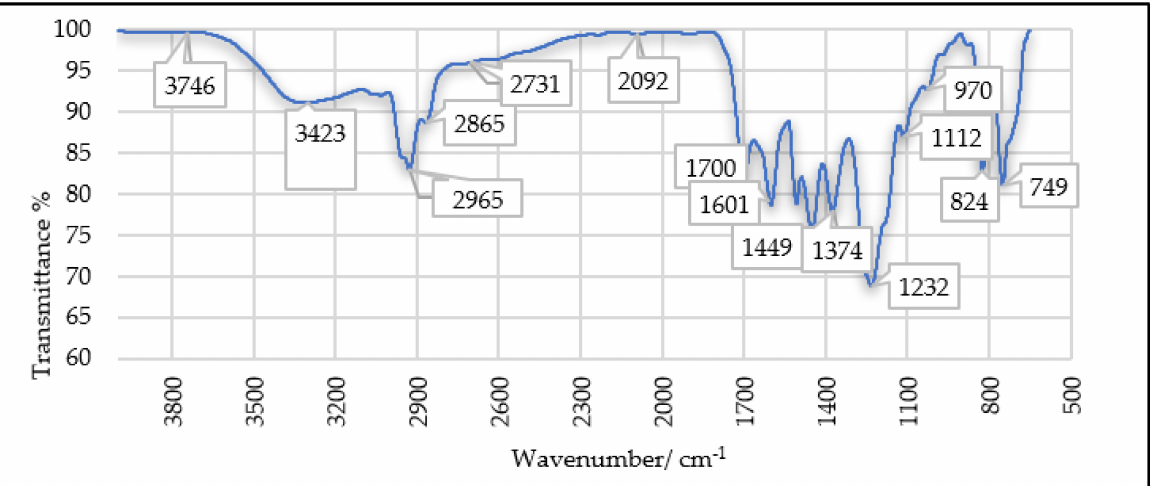
Figure 3. FTIR spectra of pyrolysis oil product of